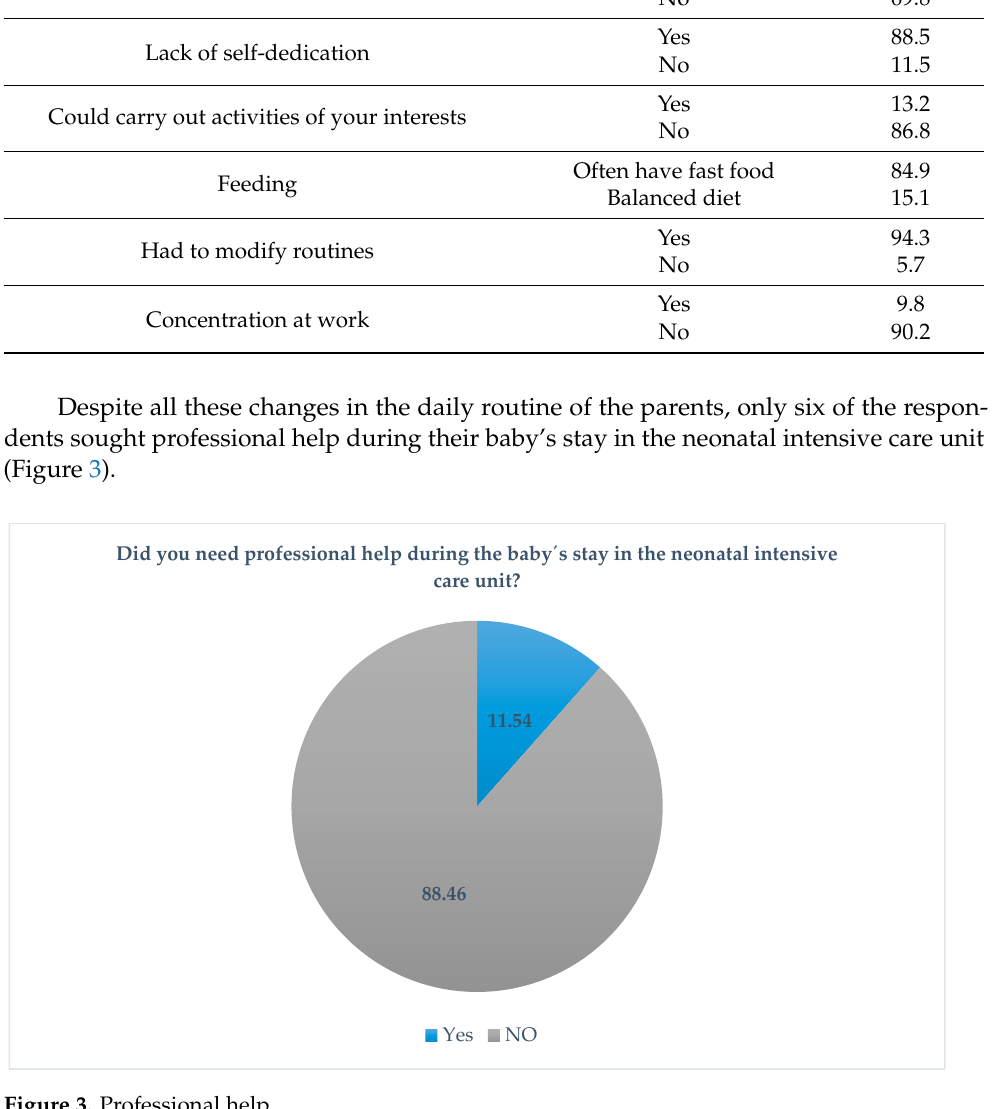
Figure 3. Professional